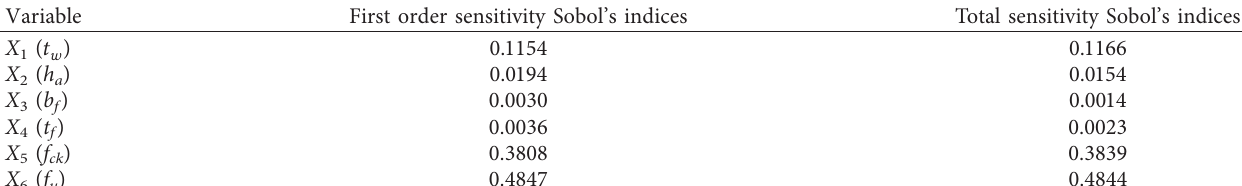
Table 9: Mean estimation with 200,000 Monte Carlo samples of the first and total Sobol’s indices for the 20-year corroded SCC beams.